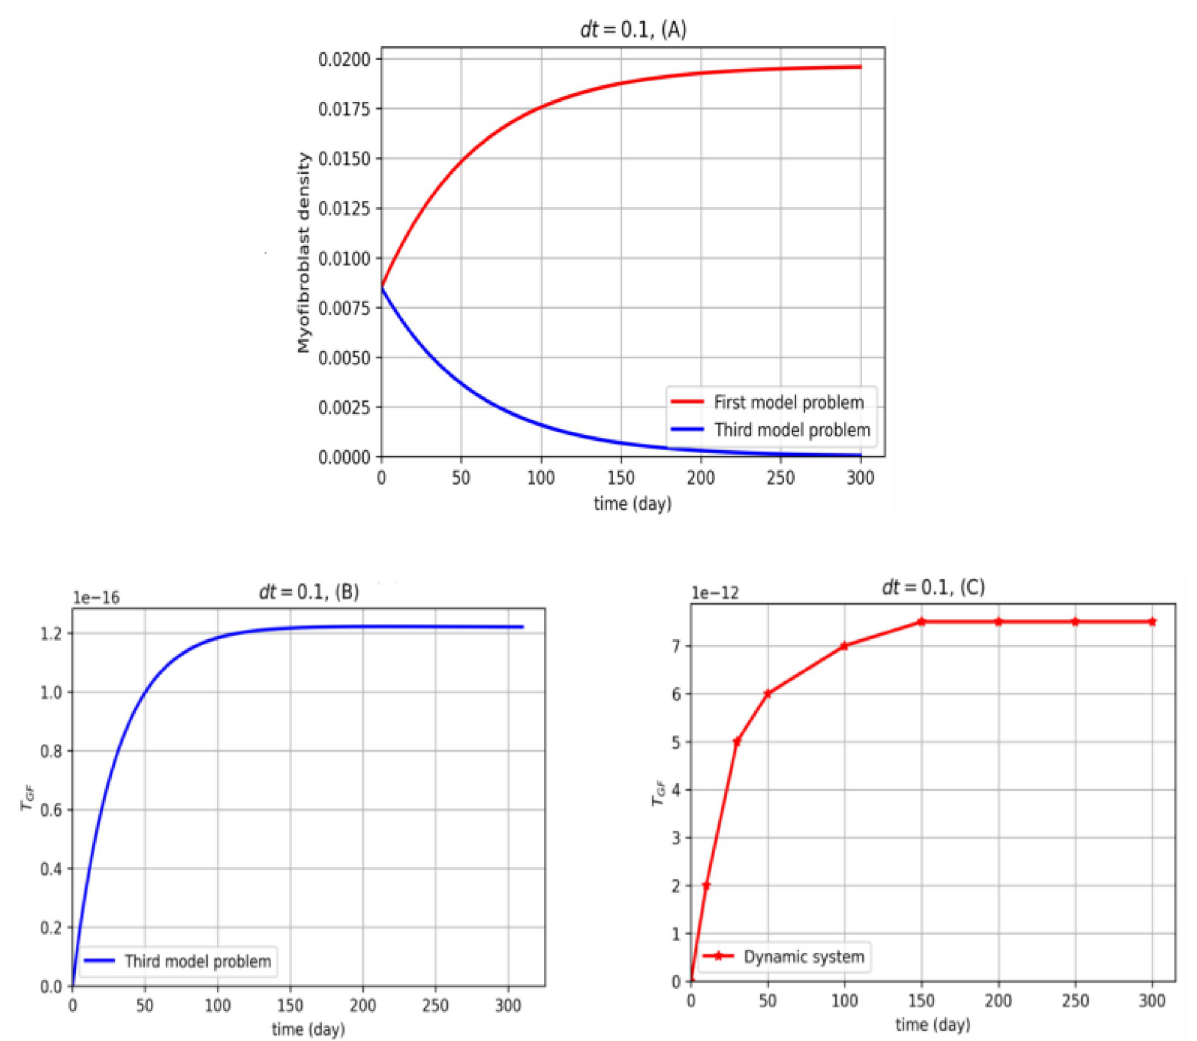
Fig 6. Improving second optimal control problem for myofibroblast diffusion. In (A), the third model problem (34)–(37) is solved by the technique proposed in this section (blue). The first model problem (dynamic system (8) and (9)) is solved by the central finite differences explicit method (red). In (B), an optimal control problem is depicted by solving the third model problem (blue). In (C), an optimal TGF- β function is calculated using the dynamical system in Ref. [20] ( − ? − ). As it is shown in (B) the optimal TGF- β values are positive. Thus one finds out that numerical results are reasonable. In this regard, physicians in practice can prescribe anti-TGF- β drugs to restore TGF- β values to the optional values (an optimal strategy). This strategy can be applicable by prescribing anti-TGF- β drags. In solving the central finite differences explicit method all calculations are done for 36 nodes in the x-y